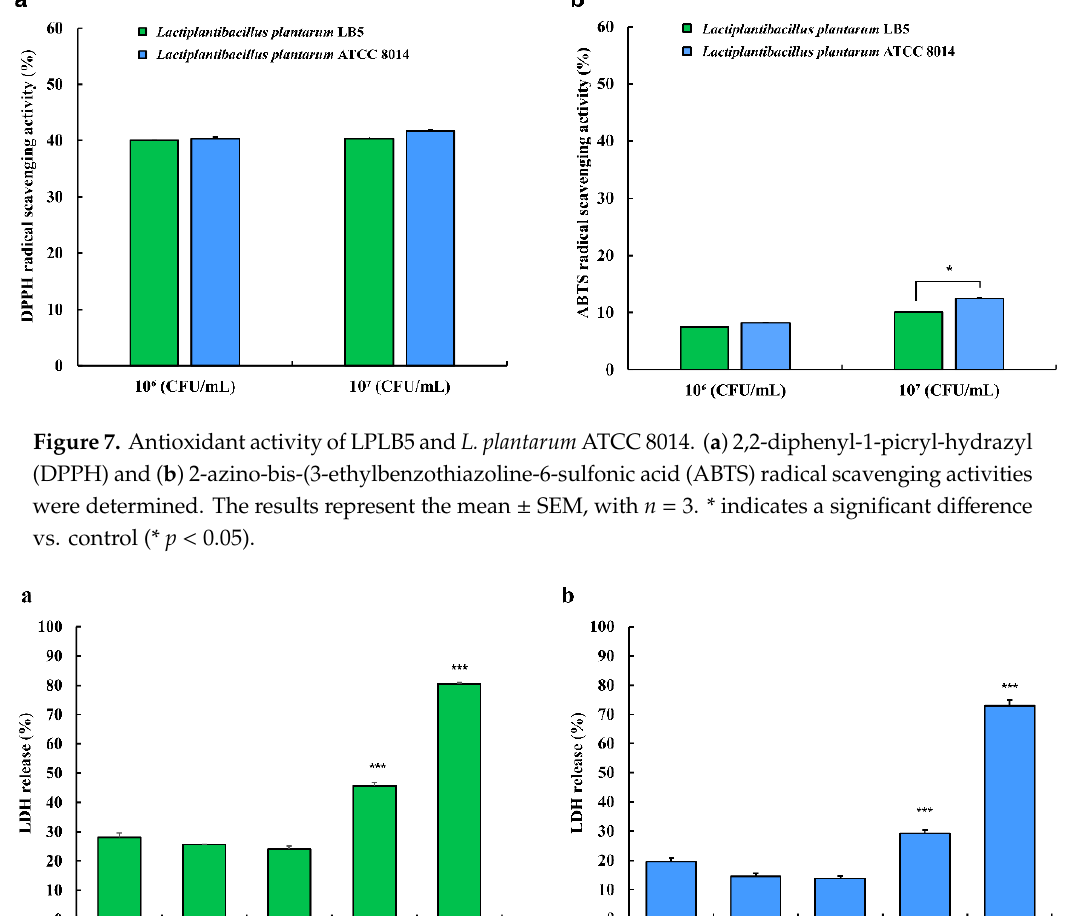
Figure 8. Effects of ( a ) LPLB5 and ( b ) L. plantarum ATCC 8014 on lactate dehydrogenase (LDH) release from human colon epithelial cells (Caco-2) cells. The Caco-2 cells were treated with LPLB5 or L. plantarum ATCC 8014 (10 6 , 10 7 , 10 8 , and 10 9 CFU/mL) for 24 h. The results represent the mean ± SEM, with n = 3. *** indicates a significant difference vs. control (*** p < 0.001).